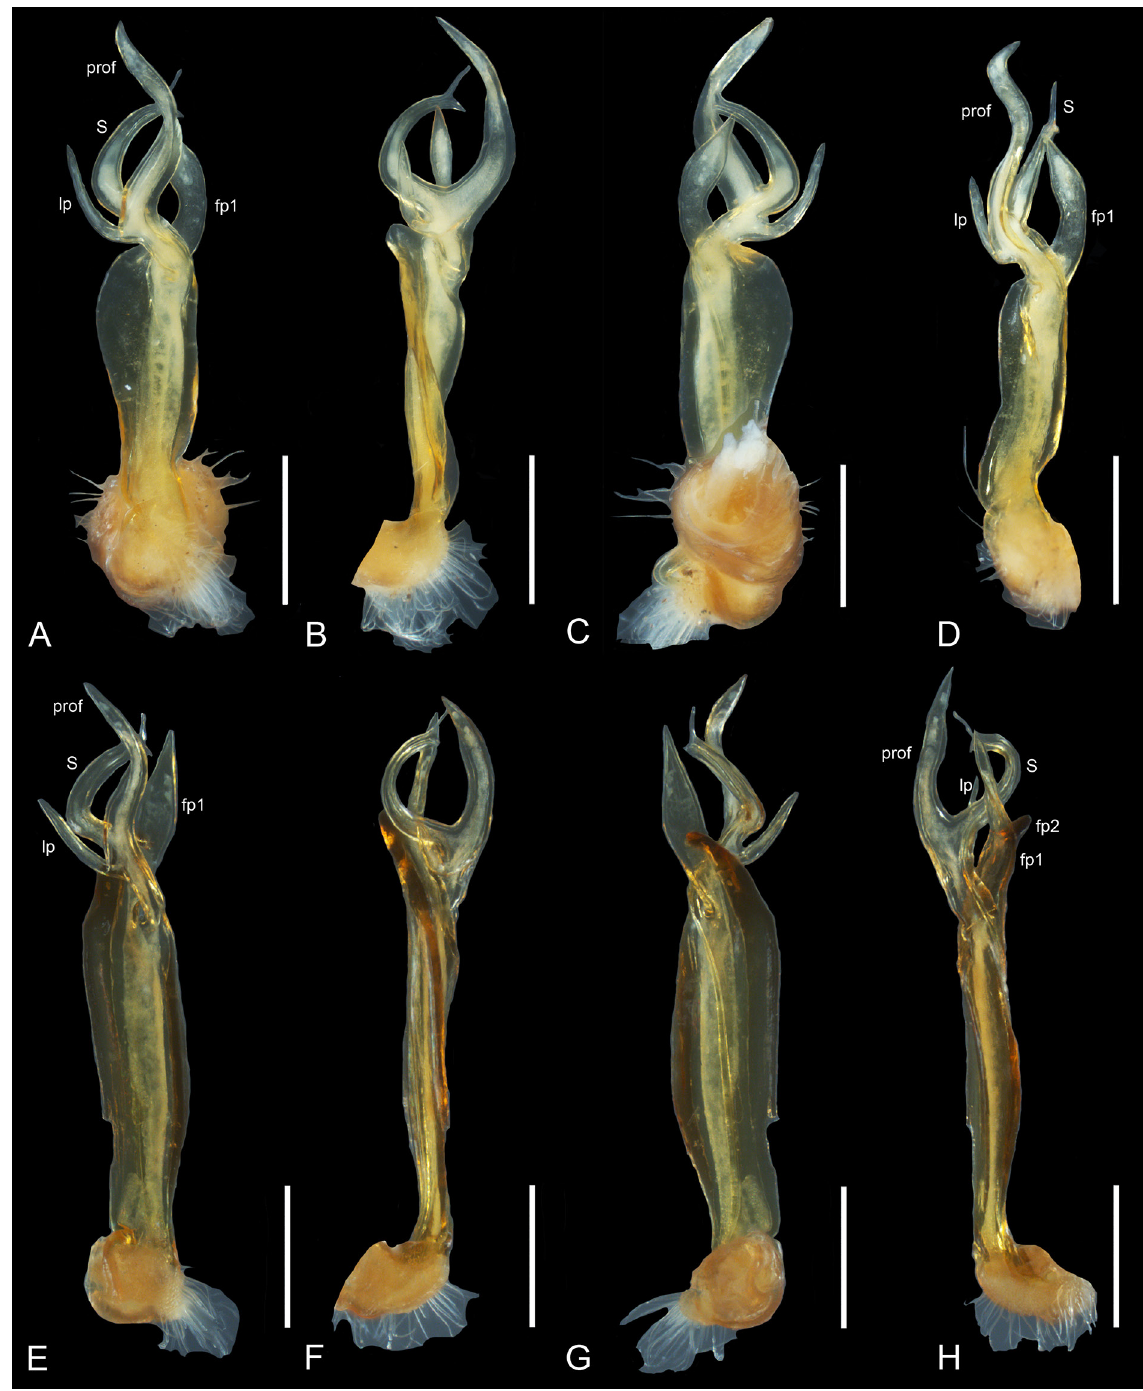
Fig. 16. Pogonosternum laetificum Jeekel, 1982, ♂, right gonopod. A–D . ANIC 64-000049 from Cumberland Valley Reserve. E–H . NMV K10249 from Murrindindi River. A, E . Posterior view. B , F . Lateral view. C, G . Anterior view. D, H . Mesal view. Scale bars: 0.5